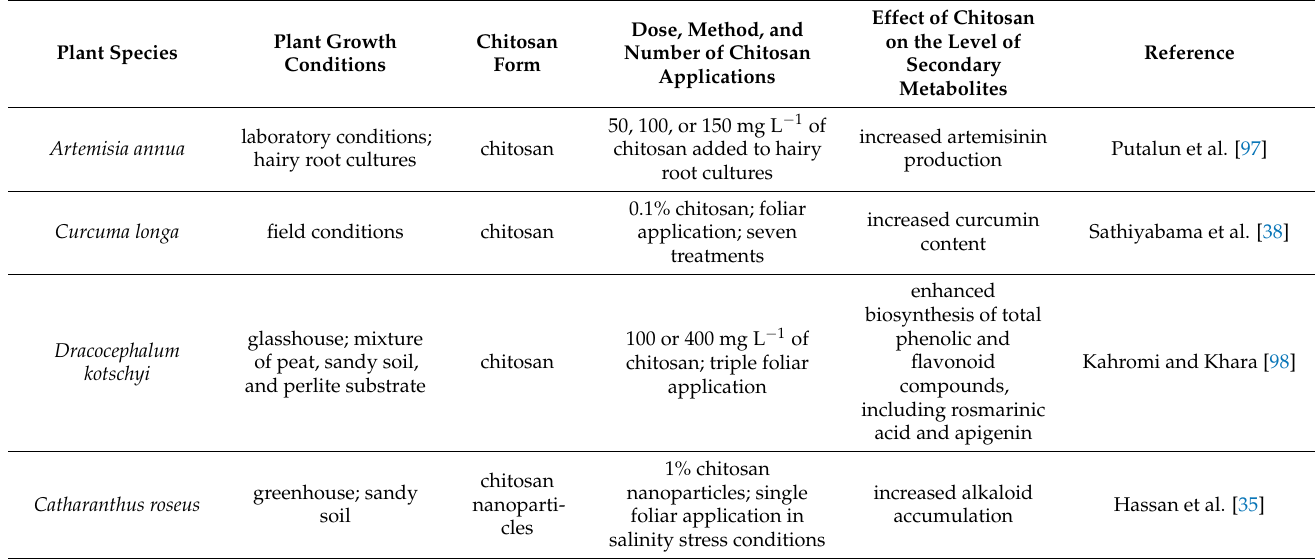
Table 1. Effects of application of chitosan and its derivatives on the level of secondary metabolites in selected plant